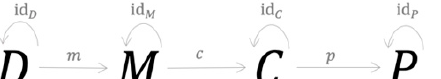
Figure 1. Structure of the credit risk modeling process underlying current approaches.